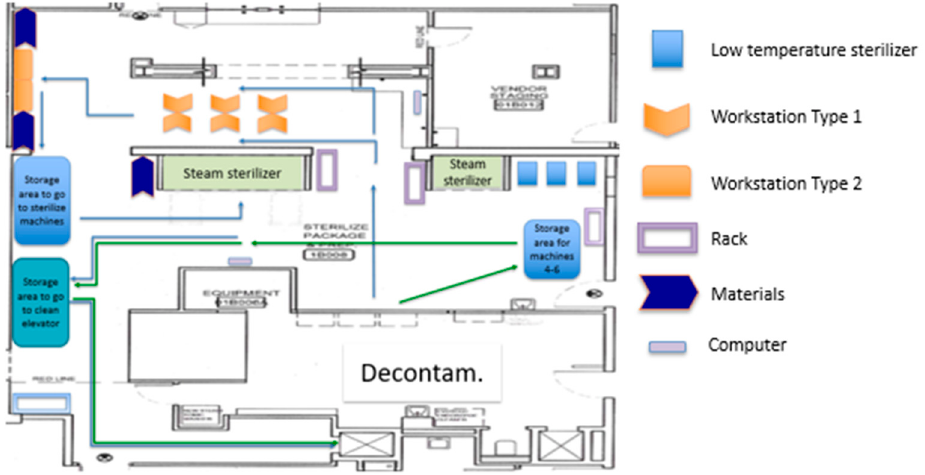
Figure 11. Proposed layout #2.